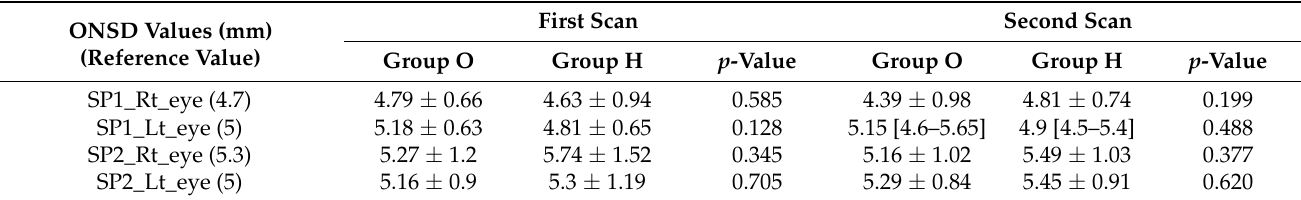
Table A6. Differences in the ONSD measurement values between